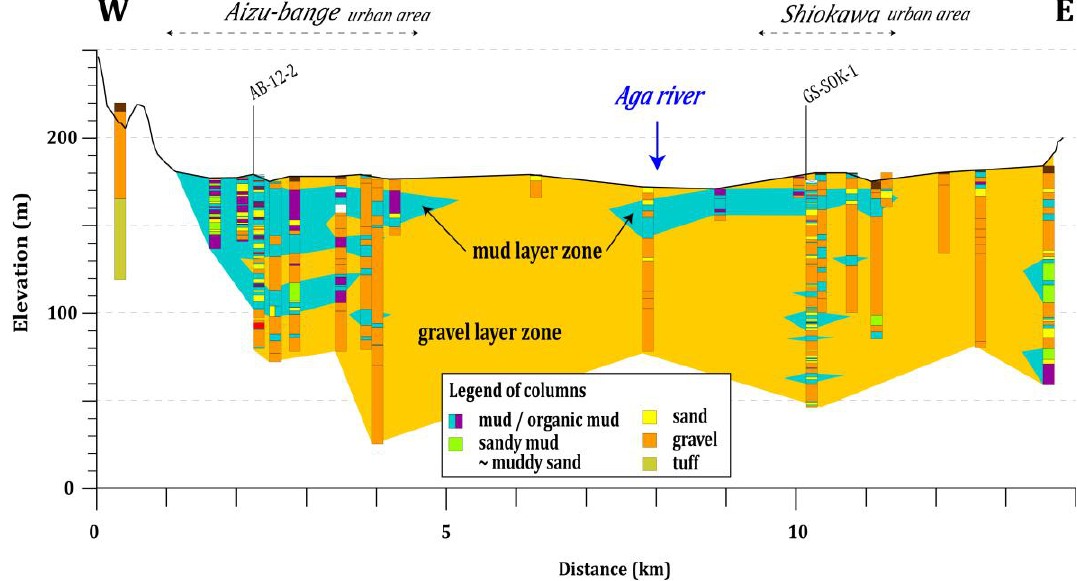
Figure 4. W-E cross section shown in Figure 1b. Columns show sedimentary cores, boring, and snow melting well logs.